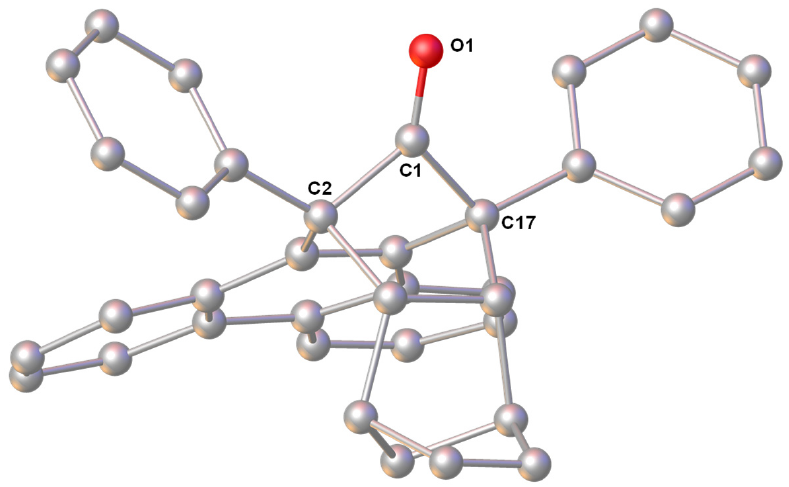
Figure 3. Crystal structure of 3 with key atoms highlighted and hydrogen atoms